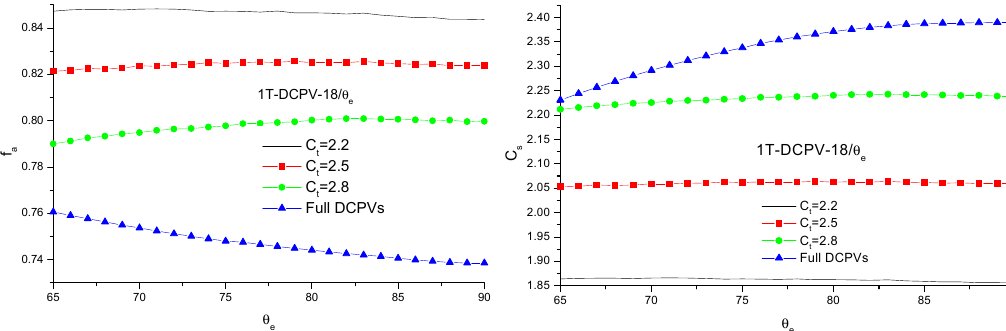
Figure 20. Effects of θ e on the annual average optical efficiency ( Left ) and collectible radiation ( Right ) θ of 1T-DCPV-18/ θ e Figure 20 . Effects of e on the annual average optical efficiency ( Left ) and collectible radiation θ ( Right ) of 1T-DCPV-18/ e .